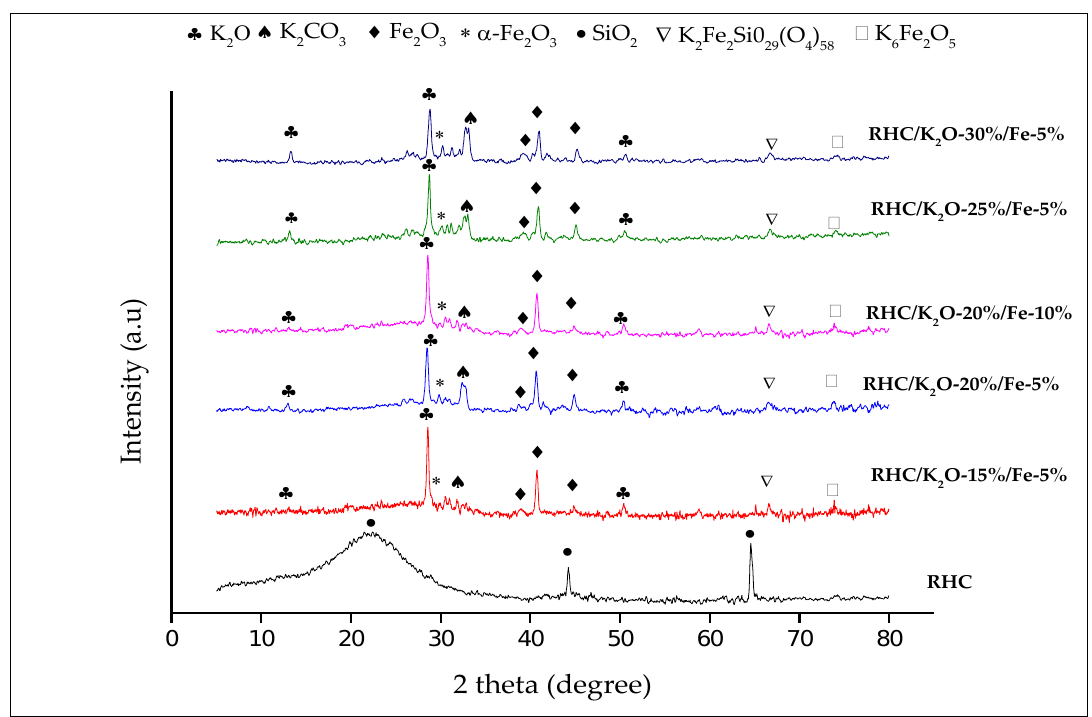
Figure 1. X-ray diffraction (XRD) patterns of rice husk char (RHC) and RHC-derived catalysts. Figure 1. X-ray di ff raction (XRD) patterns of rice husk char (RHC) and RHC-derived